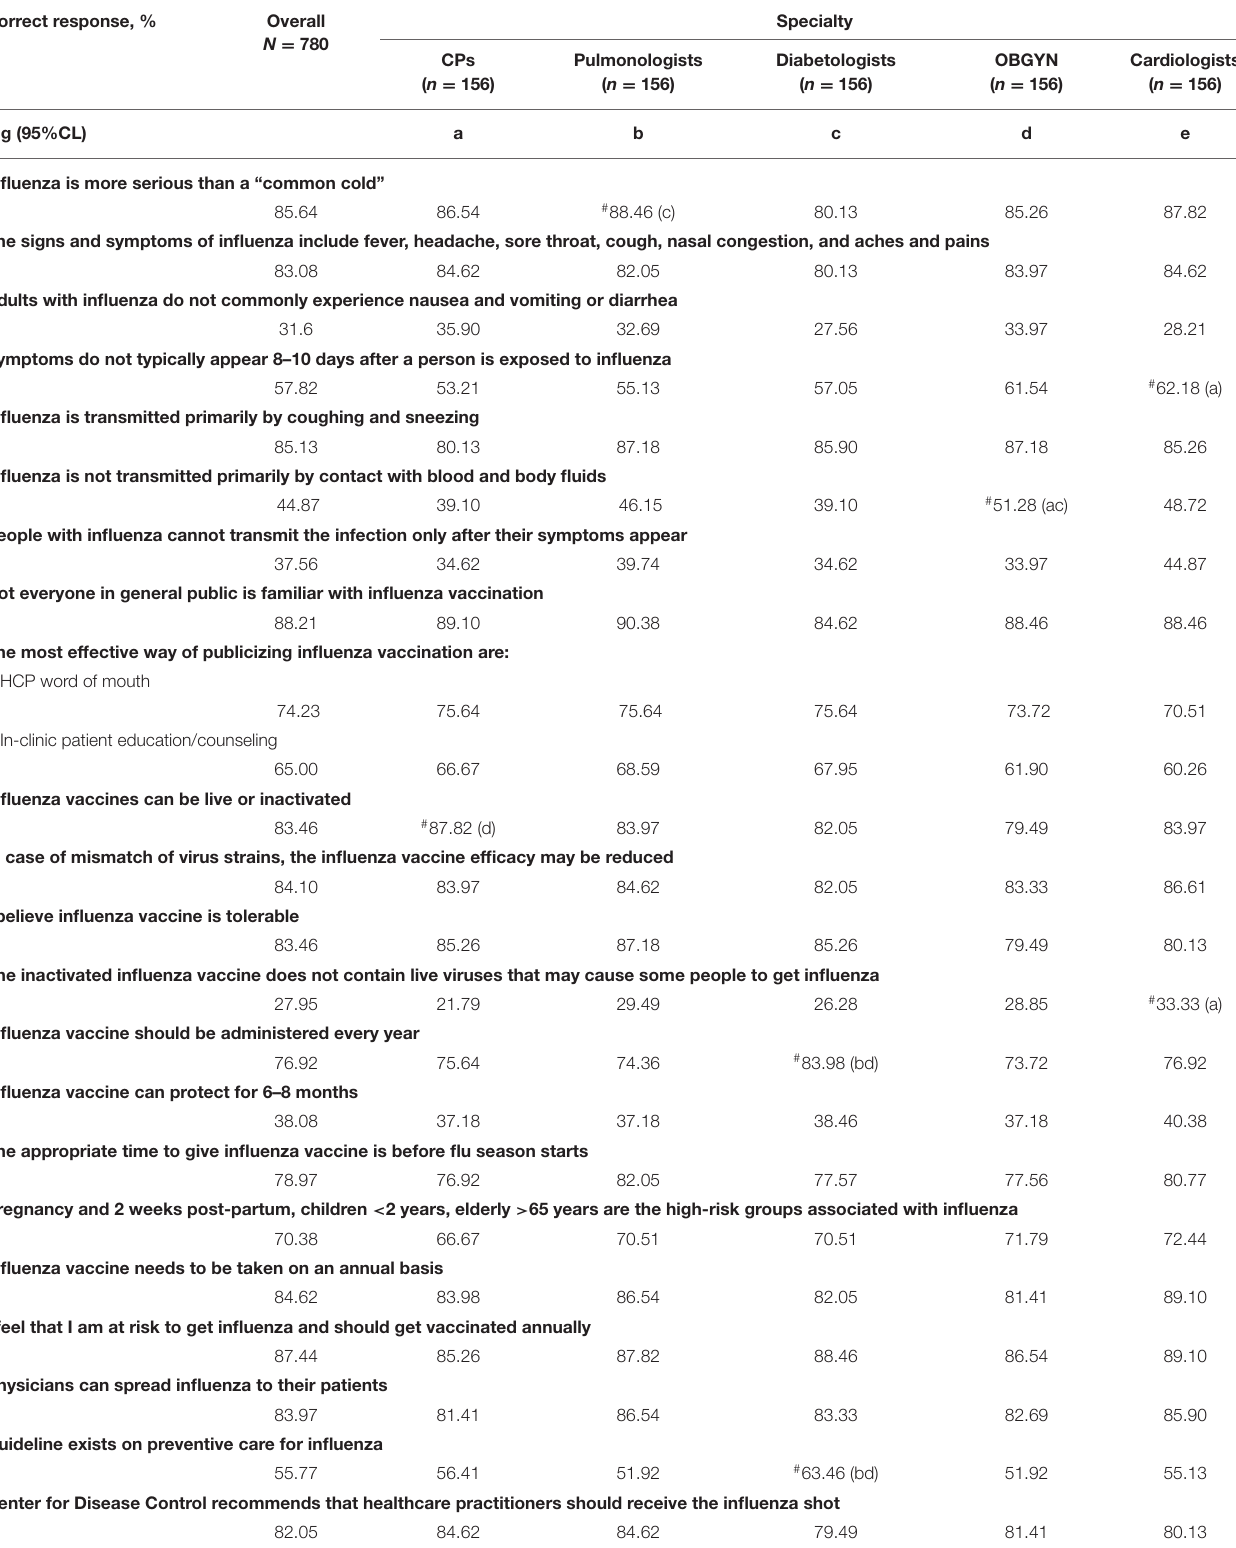
TABLE 2 | Physician awareness toward influenza and influenza vaccination. Correct response, % Overall